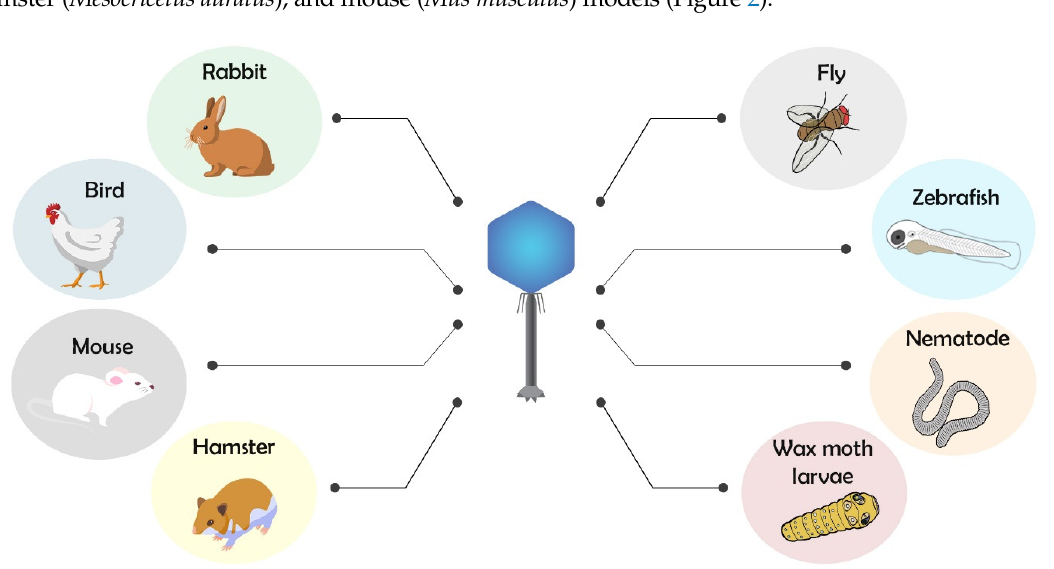
Figure 2. Animal models used for bacterial infection and phage therapy application.